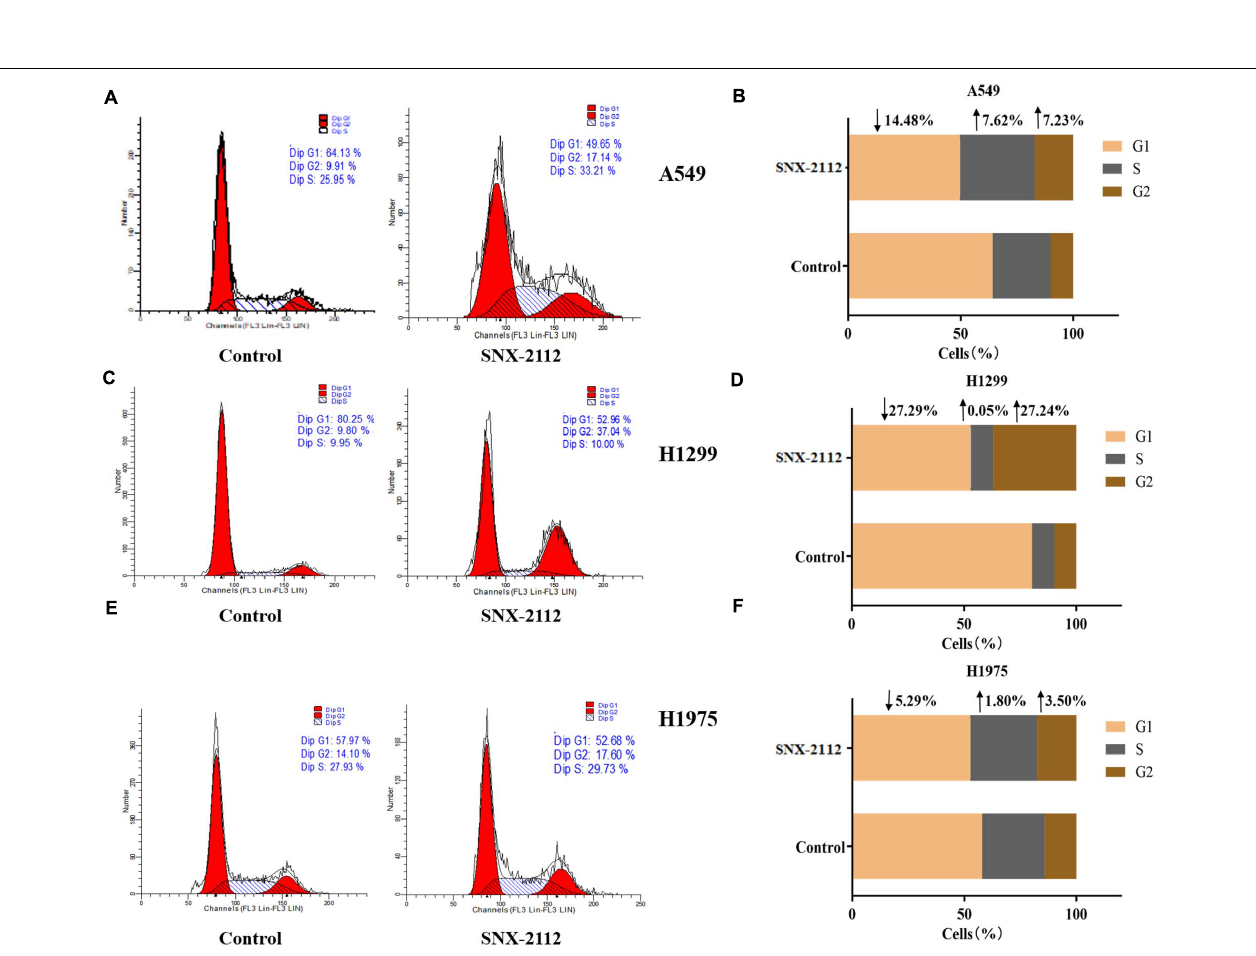
FIGURE 2 | SNX-2112 induced NSCLC cell cycle arrest. Cell cycle distribution for A549 cells (A) , H1299 cells (C) , and H1975 cells (E) treated with SNX-2112 or DMSO for 72 h detected by DNA flow cytometry assay. The DNA content in different phase of A549 cells (B) , H1299 cells (D) , and H1975 cells (F) treated with SNX-2112 or DMSO for 72 h. SNX-2112 induced A549, H1975, and H1299 cells cycle arrest at S and G2 phase or G2 phase. Annotations: Control, cells treated with DMSO for 72 h; SNX-2112, cells treated with SNX-2112 for 72 h.